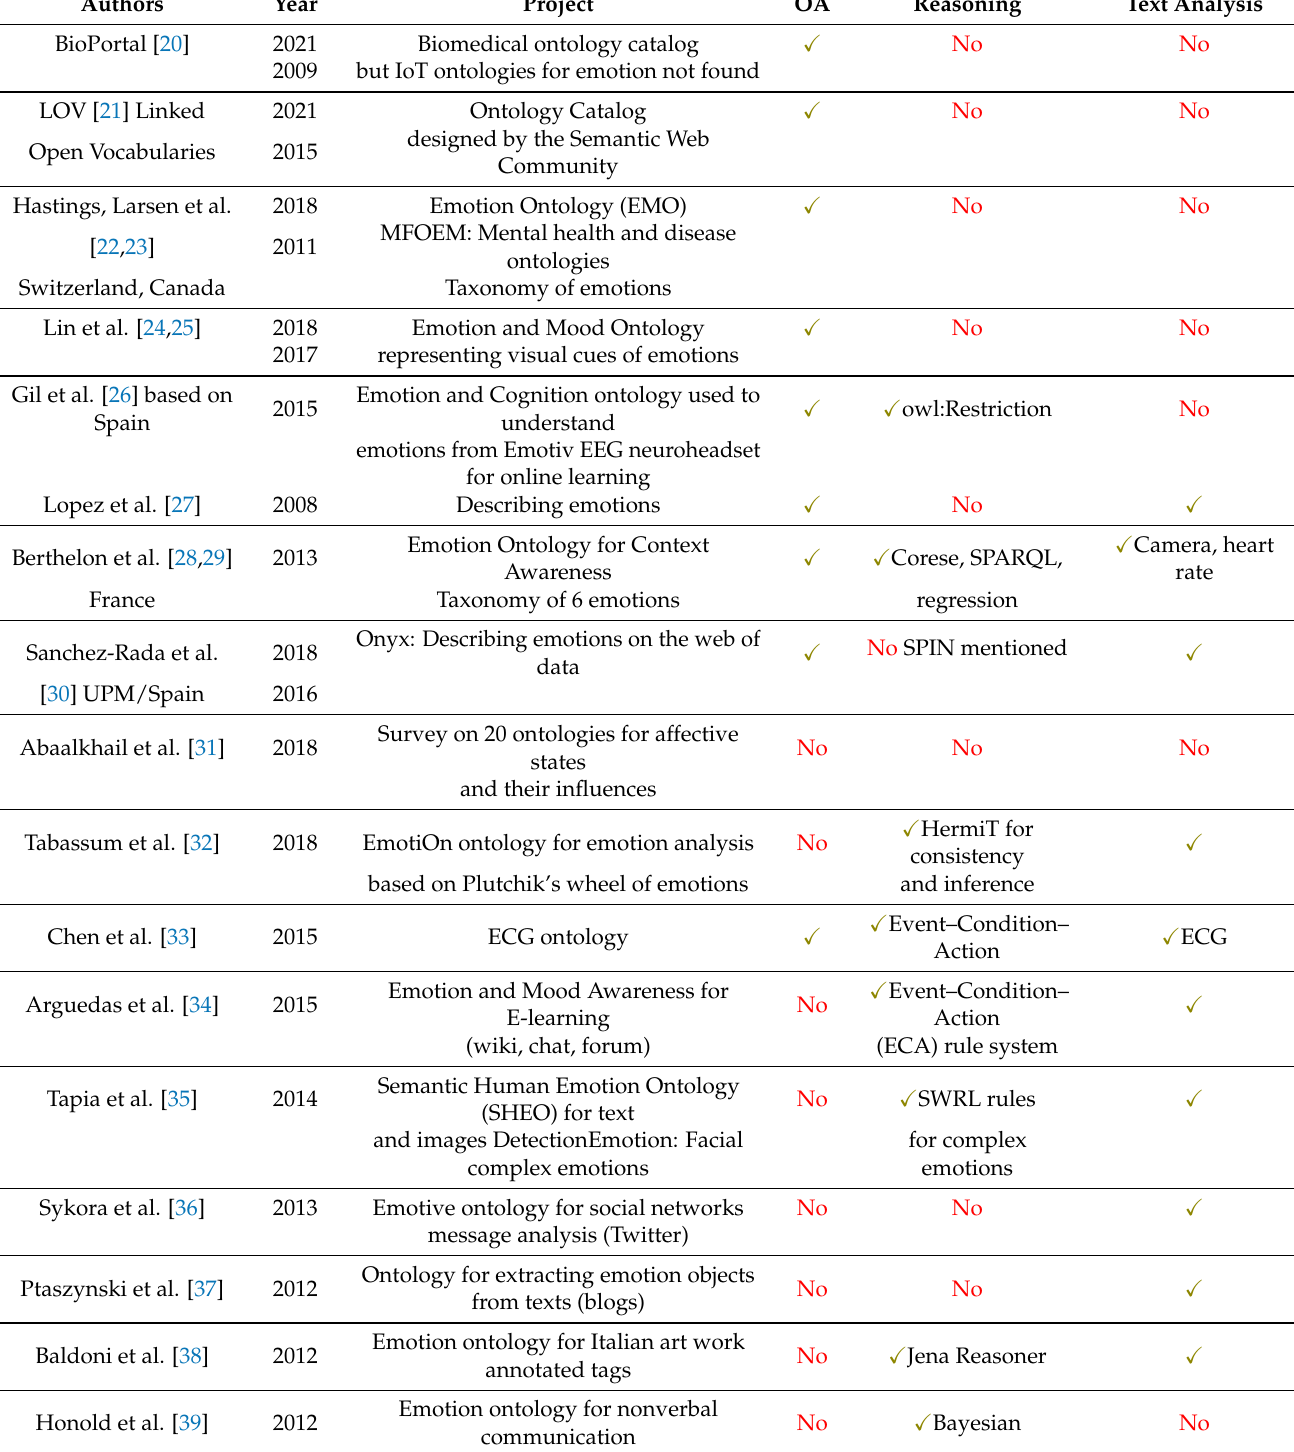
Table 1. Related work synthesis: Ontology-based emotional projects and reasoning mechanisms employed. Legend: Ontology Availability (OA); when the code is available, the ontologies are classified on the top. Then, the ontology-based projects are classified by year of publications. Several years can appear to highlight that the ontology was maintained from the first publications to the latest publications that we are aware